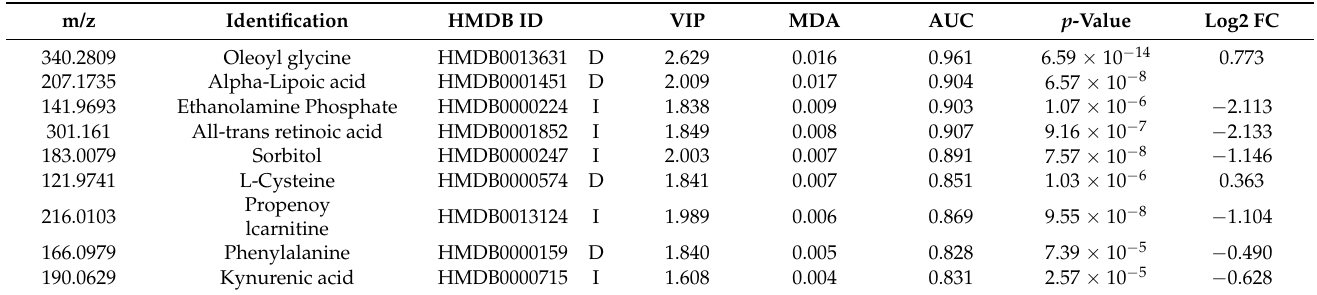
Table 2. The m/z values for the most significant metabolites from serum samples and their identifica- tion according to the HMDB database. These metabolites were considered predictive given their VIP and MDA